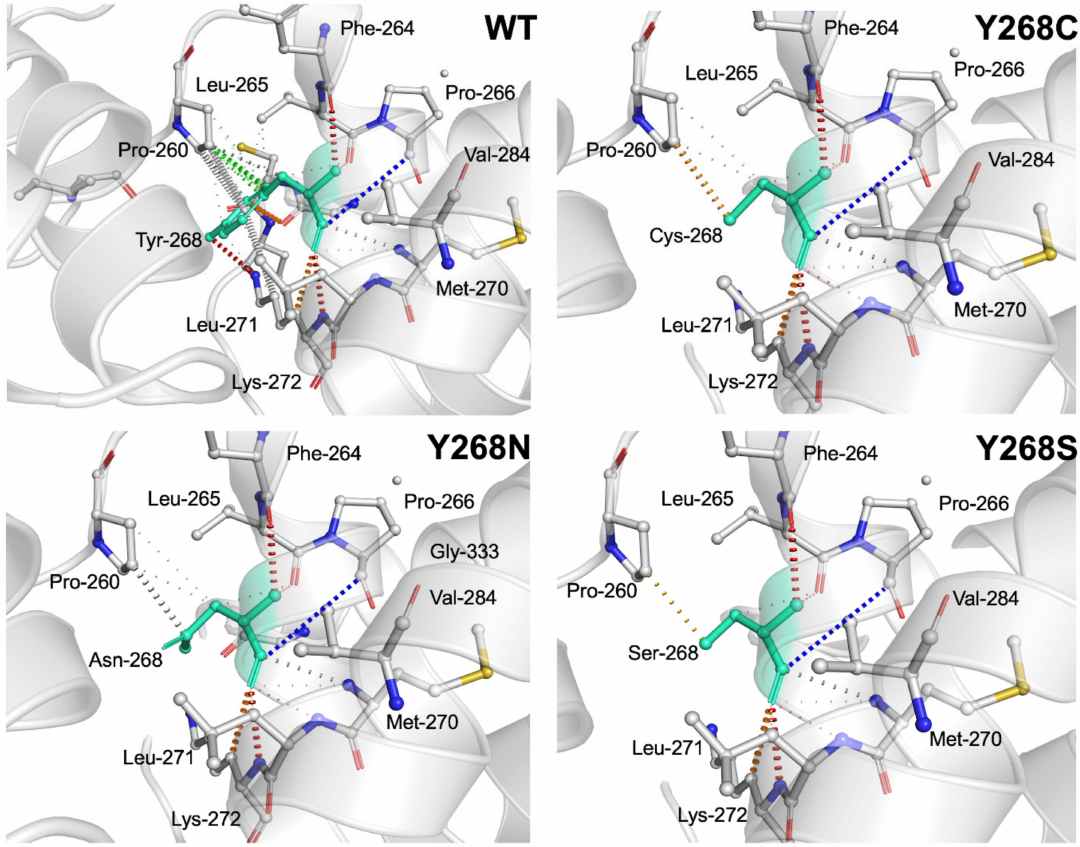
Figure 3. Illustration of interatomic interactions occurring around residue 268 in the WT (wild-type), and Y268C, Y268N, Y268S mutant proteins. Residue 268 in the WT and mutant proteins is colored in light green and shown as sticks. The respective chemical interactions are labeled as dotted lines and colored as follows: Hydrogen bond—(red), weak hydrogen bonds—(orange), hydrophobic contacts—(green), amide-amide contact—(blue) and ionic interactions—(gold). Amino acid residues are also colored according to type, namely; nitrogen (blue), oxygen (red) and sulphur